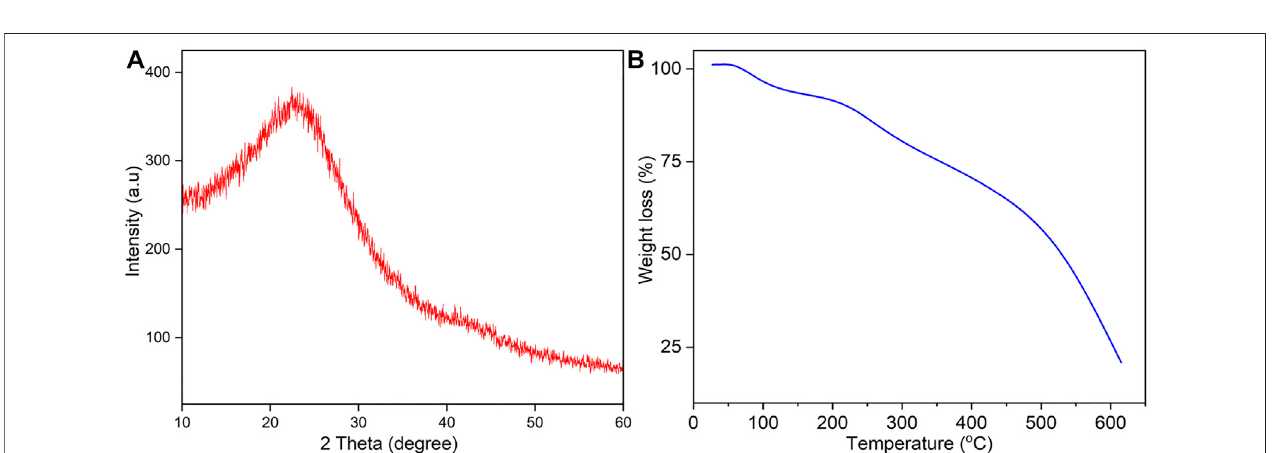
FIGURE 1 | (A) XRD pattern, (B) TGA